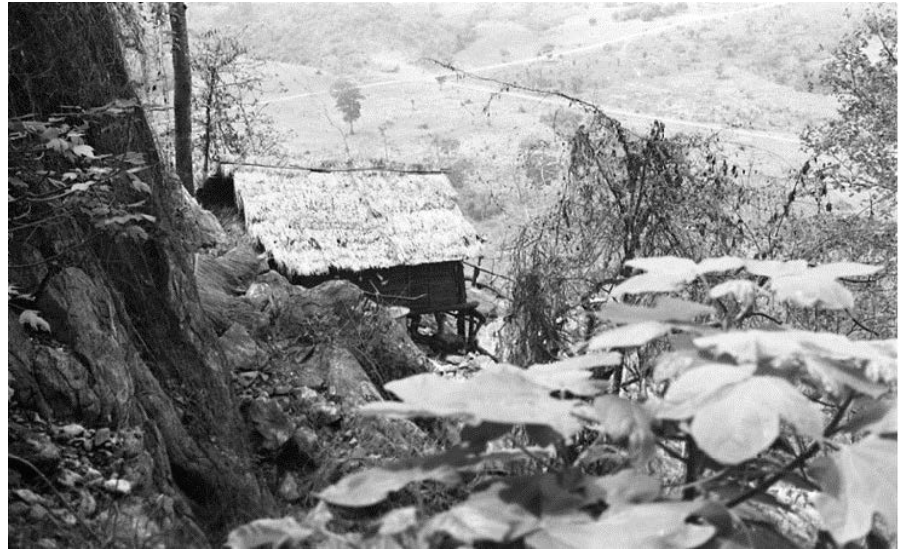
Figure 2. House and workspace constructed in 1973 outside the cave, to facilitate the onsite processing of samples.